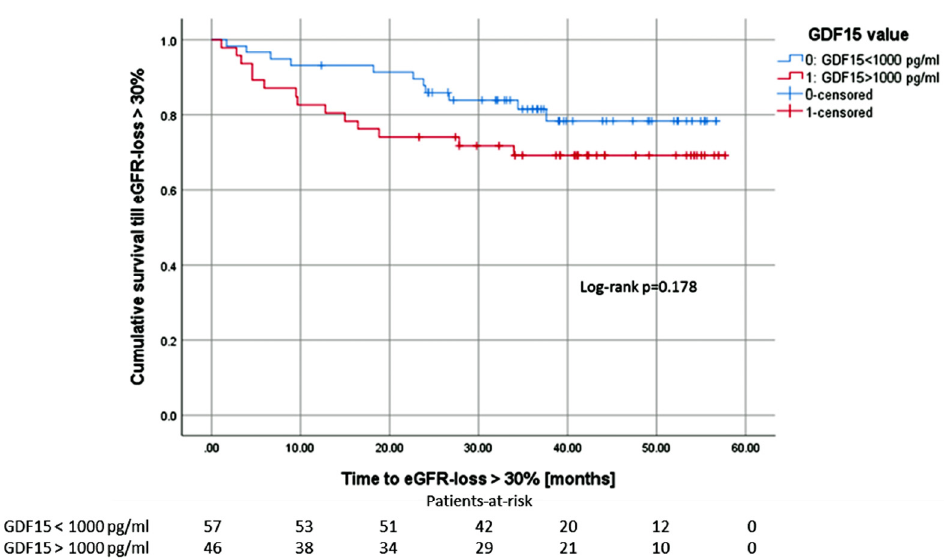
Figure 7. Patients with GDF15 values above 1000 pg / ml showed a higher incidence of eGFR-loss > 30% within the first 18 months after measurement compared to patients with GDF15 values below 1000 pg / ml. Taking the whole observation period into account, there is no statistically significant difference.